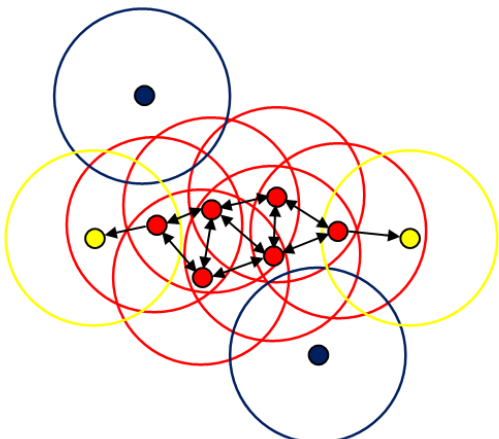
Figure 4. The explanation of the density-based spatial clustering of application with noise (DBSCAN) algorithm: the red points represent the core points, the yellow points represent the border points, and the blue points represent the noise points. The radius of the circle represents the distance threshold.